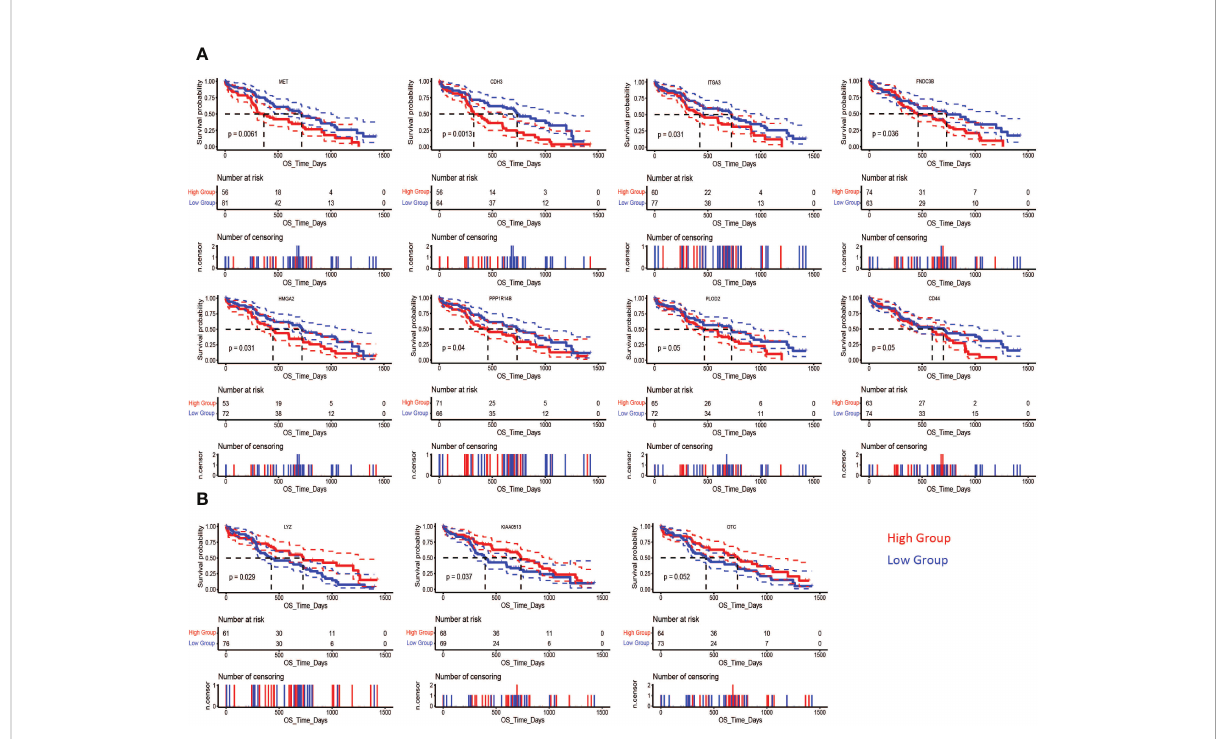
FIGURE 11 Association of differentially expressed proteins and survival in PDAC. In the CPTAC-PDAC cohort, Kaplan-Meier analysis shows that poor overall survival (OS) was correlated (A) high expression of MET (log-rank test, P= 0.0061), CDH3 (log-rank test, P= 0.0013), ITGA3 (log-rank test, P= 0.031), FNDC3B (log-rank test, P= 0.036), HMGA2 (log-rank test, P= 0.031), PPP1R14B (log-rank test, P= 0.04), and PLOD2 (log-rank test, P= 0.05) CD44 (log-rank test, P= 0.05), and (B) low expression of LYZ (log-rank test, P= 0.029), KIAA0513 (log-rank test, P= 0.037), and OTC (log- rank test, P=